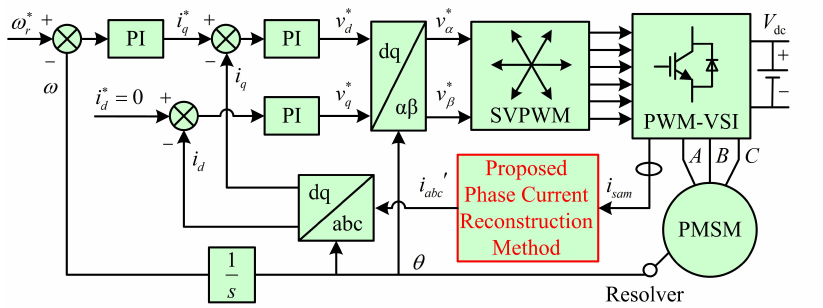
Figure 10. PMSM control strategy based on the novel phase current reconstruction method.